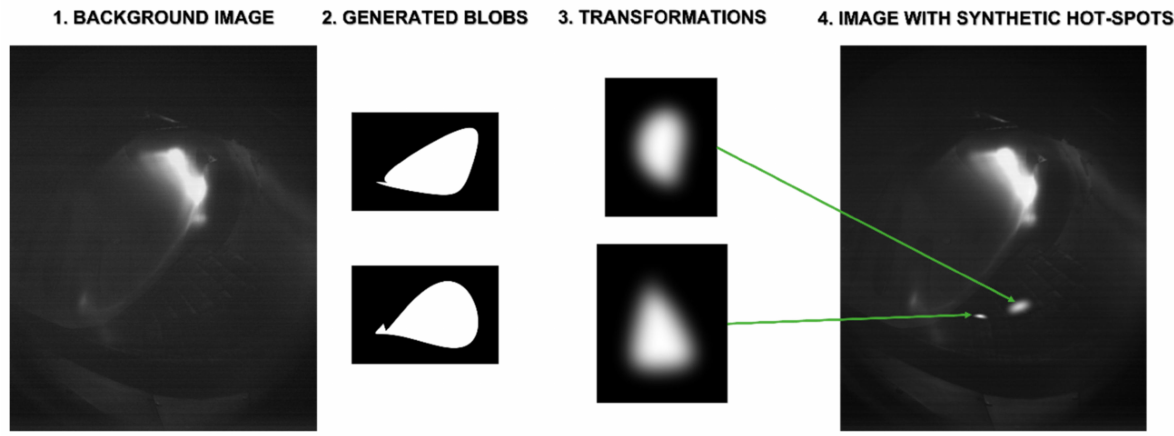
Figure 3. The steps in the process of generating images with synthetic